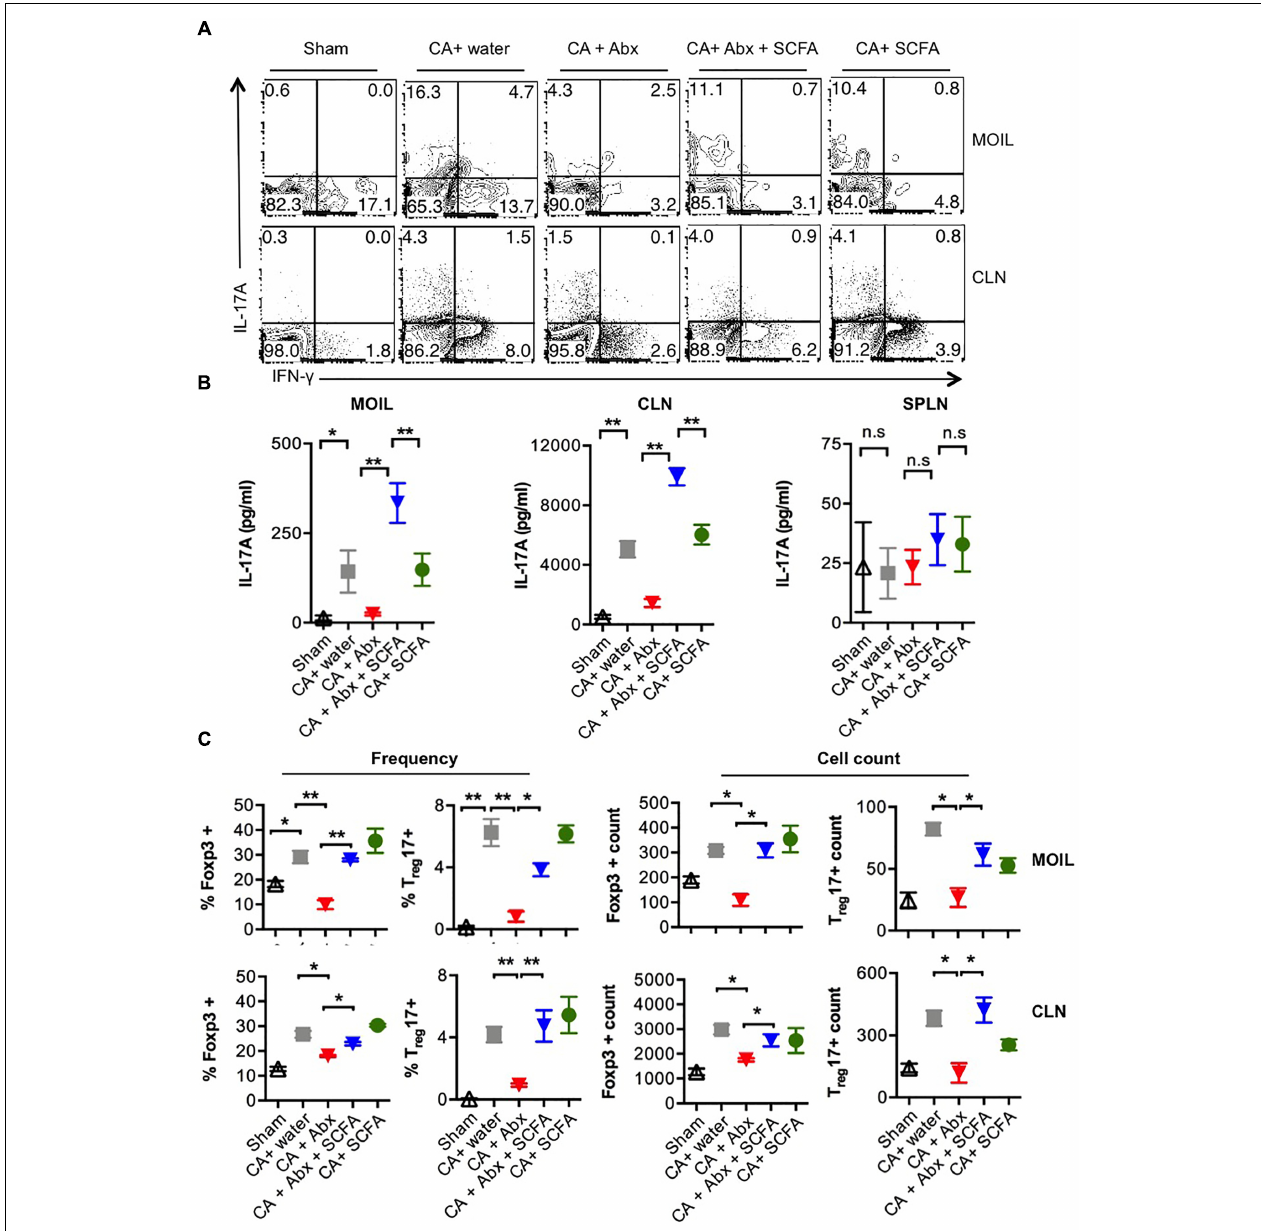
FIGURE 2 | Abx treatment leads to Th17 and T reg cell reduction, and SCFAs restore these cell populations during OPC. (A) Mice were treated with Abx and SCFA, and infected as in Figure 1 ( n = 4/group). On day 1 after second infection, cells isolated from tongue (MOIL) and draining CLN and were re-stimulated before cytokine analyses. Each FACS plot represents individual mouse in a group. Flow cytometric contour plots showing expression of IFN- γ and IL-17A (all gated on CD4+ cells). (B) ELISA quantification of IL-17A in supernatants collected from MOIL and CLN cultures re-stimulated as in (A) . (C) MOIL and CLN cultures re-stimulated as in A for cytokine assessment. Statistic analyses on Foxp3+ and Foxp3+IL-17A+ cells. Mean values from four individual data points (mice)/group are shown. Note the differences in “Y-axis.” Statistical analyses was done using Mann–Whitney test ( ∗ P < 0.05 and ∗∗ P < 0.005). Data represent triplicate